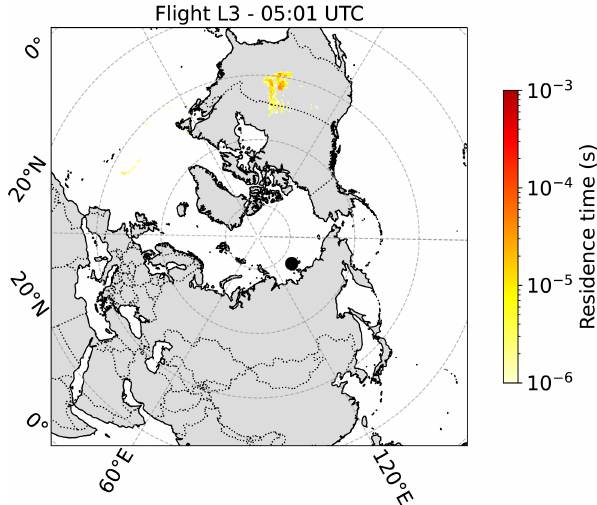
Figure C1. The 10d potential emission sensitivity (PES) with a threshold altitude of 500m for particles released at 05:01UTC at an altitude of 5256m. The black dot represents the position of the receptor.